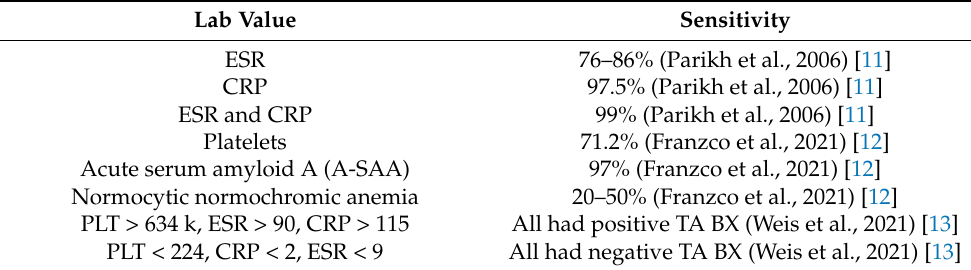
Table 2. Sensitivity of Lab Testing for GCA Patients by